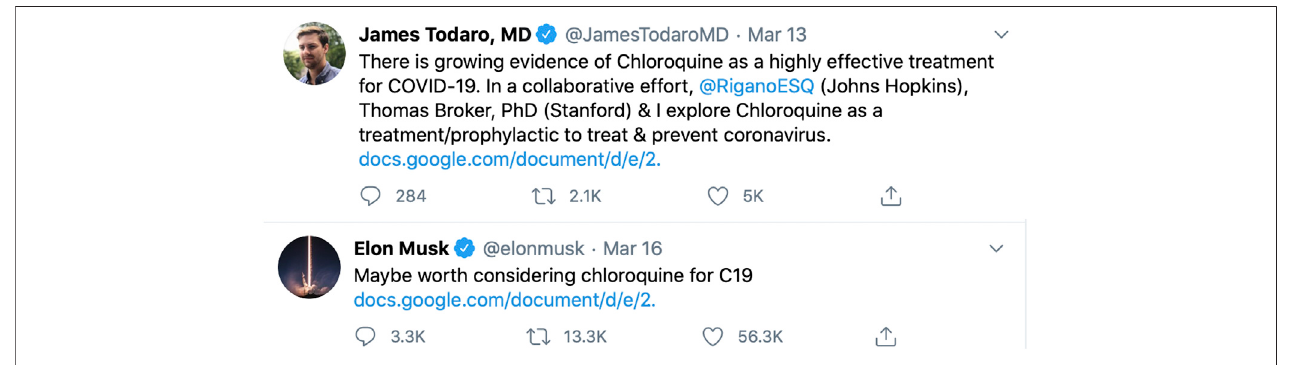
FIGURE 1 | James Todaro ’ s and Elon Musk ’ s tweets.